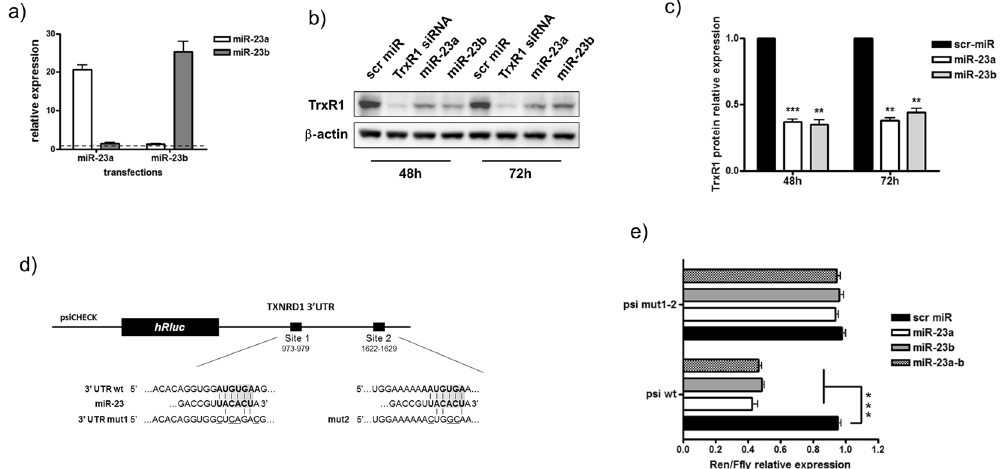
Figure 5. miR-23 overexpression negatively regulates TrxR1 levels by targeting its 3 ′ UTR. C2C12 myoblasts were transfected with mimic miR-23a, mimic miR-23b or a scramble miR (scr miR). ( a ) RT-qPCR showing the expression of miR-23a and miR-23b 48 hours after transfection. ( b ) Representative western blot displaying TrxR1 protein levels at 48 and 72 hours after transfection. The lysates originated by C2C12 transfected with an siRNA against the TrxR1 mRNA sequence (TrxR1 siRNA) were loaded as positive control of TrxR1 downregulation. ( c ) Quantification of panel b performed on three independent experiments. TrxR1 proteins levels were normalized to β -actin and the value of scr miR was arbitrarily set = 1. ( d ) A schematic view of the reporter construct generated by cloning the 3 ′ UTR sequence of TrxR1 mRNA in psicheck vector downstream of renilla luciferase cDNA (psi-wt). Site-specific mutagenesis was performed to generate the reporter construct harbouring the 3 ′ UTR mutated in miR-23 binding sites 1 and 2 (psi mut1-2). ( e ) Histograms showing the relative amount of Renilla/Ffly ratio measured in lysates of C2C12 cells transfected with psi wt, psi mut1 or psi mut1-2 in the presence of scr miR, mimic miR-23a, mimic miR-23b or both (miR-23a-b). The experiment was performed three times. Each biological assay was done in